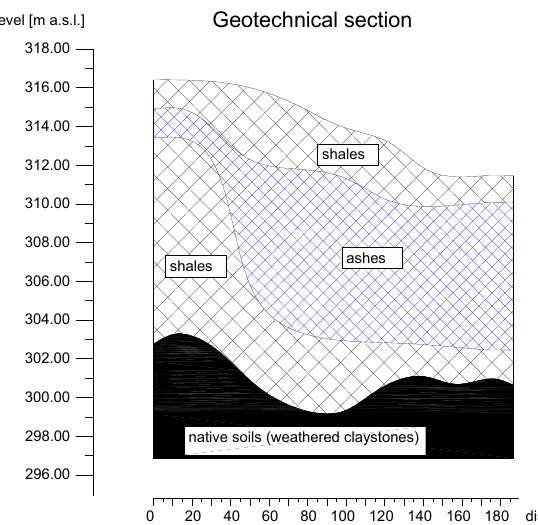
Figure 5. Representative geotechnical cross section [19].